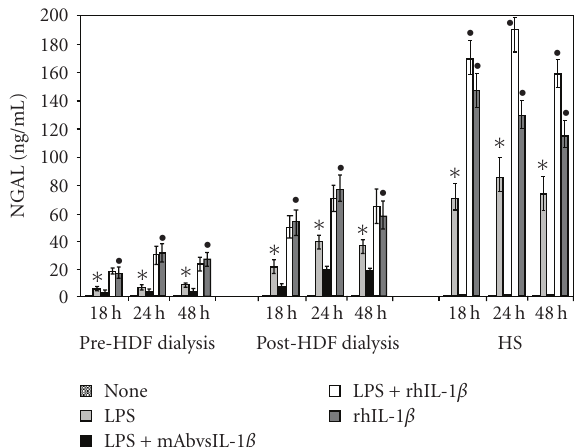
Figure 1: Role of IL-1 β on the kinetics of NGAL production by PMG from preHDF and postHDF patients and HS. ∗ Significantly di ff erent ( P < . 05) from that of unstimulated PMG. ◦ Significantly di ff erent ( P < . 05) from that of LPS-stimulated PMG. • Significantly di ff erent ( P < . 05) from that of LPS-stimulated